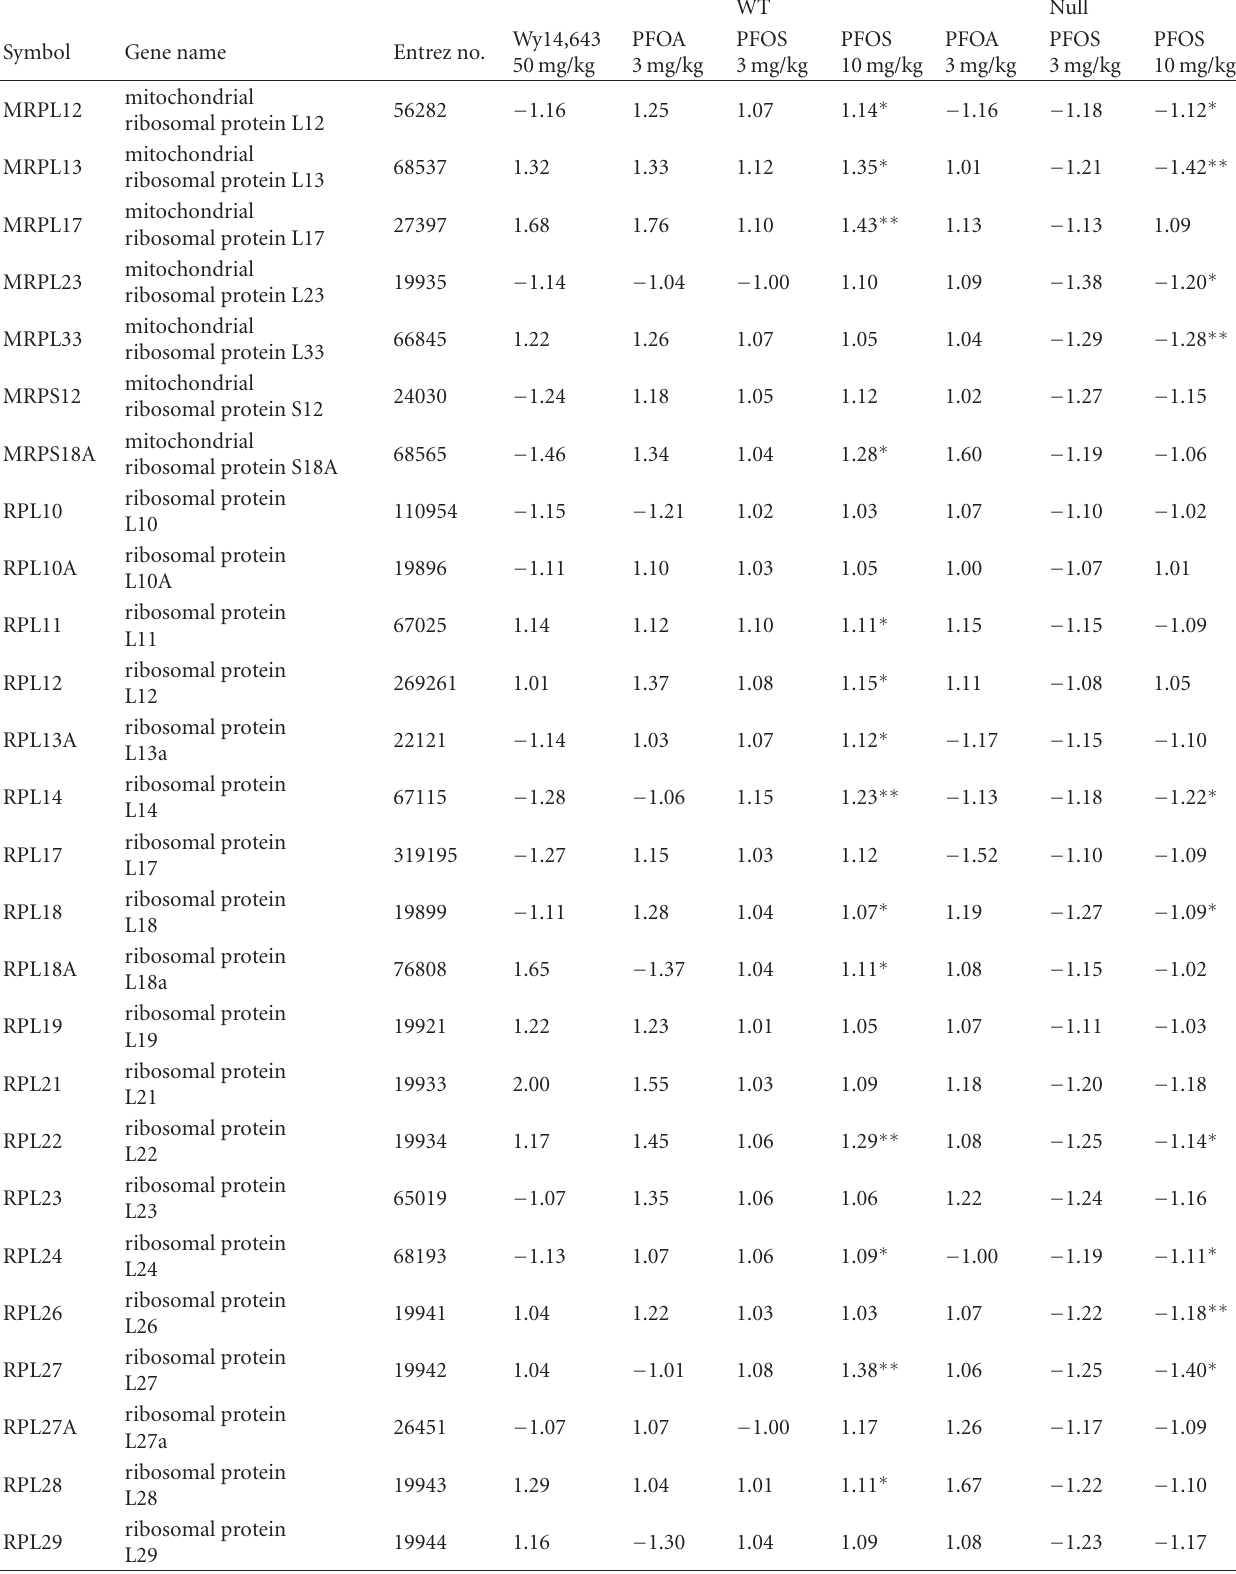
Table 10: Average fold change for genes related to ribosome biogenesis following a seven-day exposure to Wy-14,643 1 , PFOA 1 , or PFOS in wild-type and PPAR α -null male